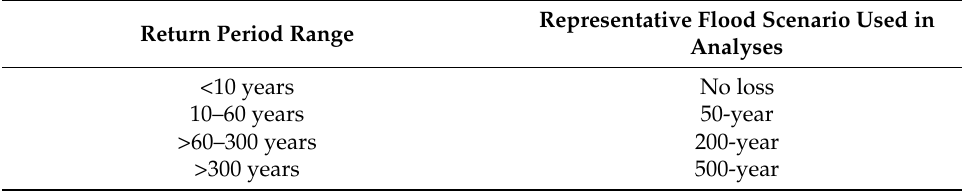
Table 9. Return period classes and flood scenarios used in the